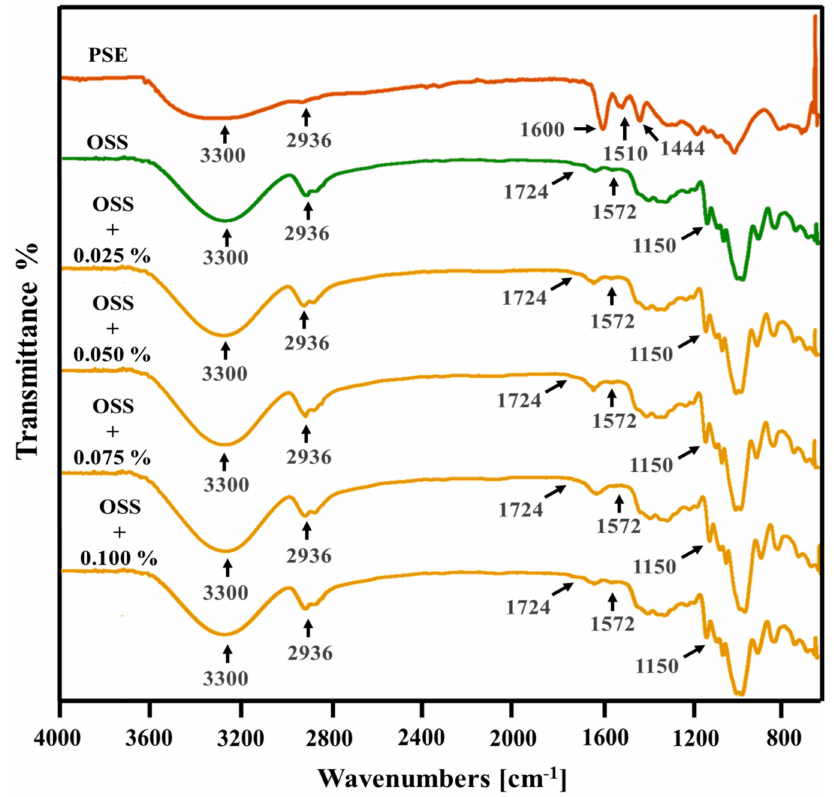
Figure 6. Fourier transform infrared (FTIR) spectra of pecan nutshell extract and octenyl succinate starch films with pecan nutshell extract. PSE: Pecan nutshell extract, OSS: octenyl succinate